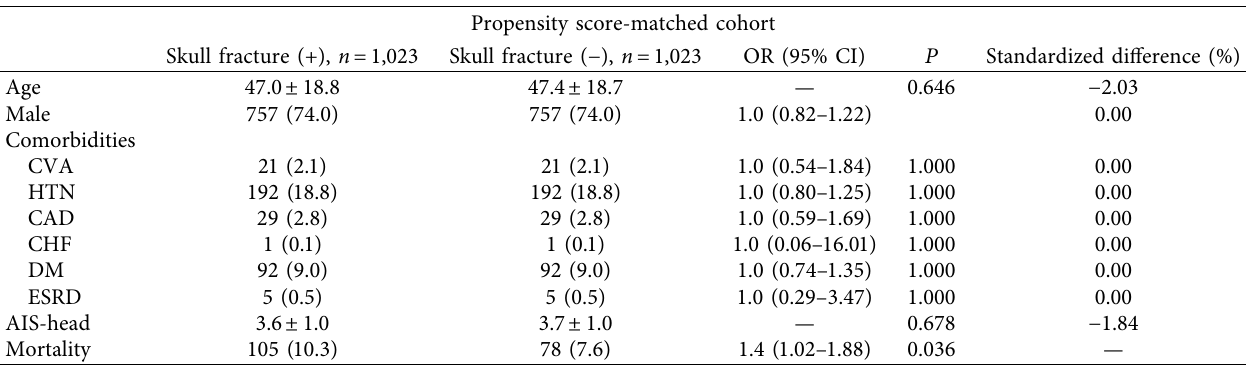
Table 3: Propensity score-matched cohort of the patients with or without skull